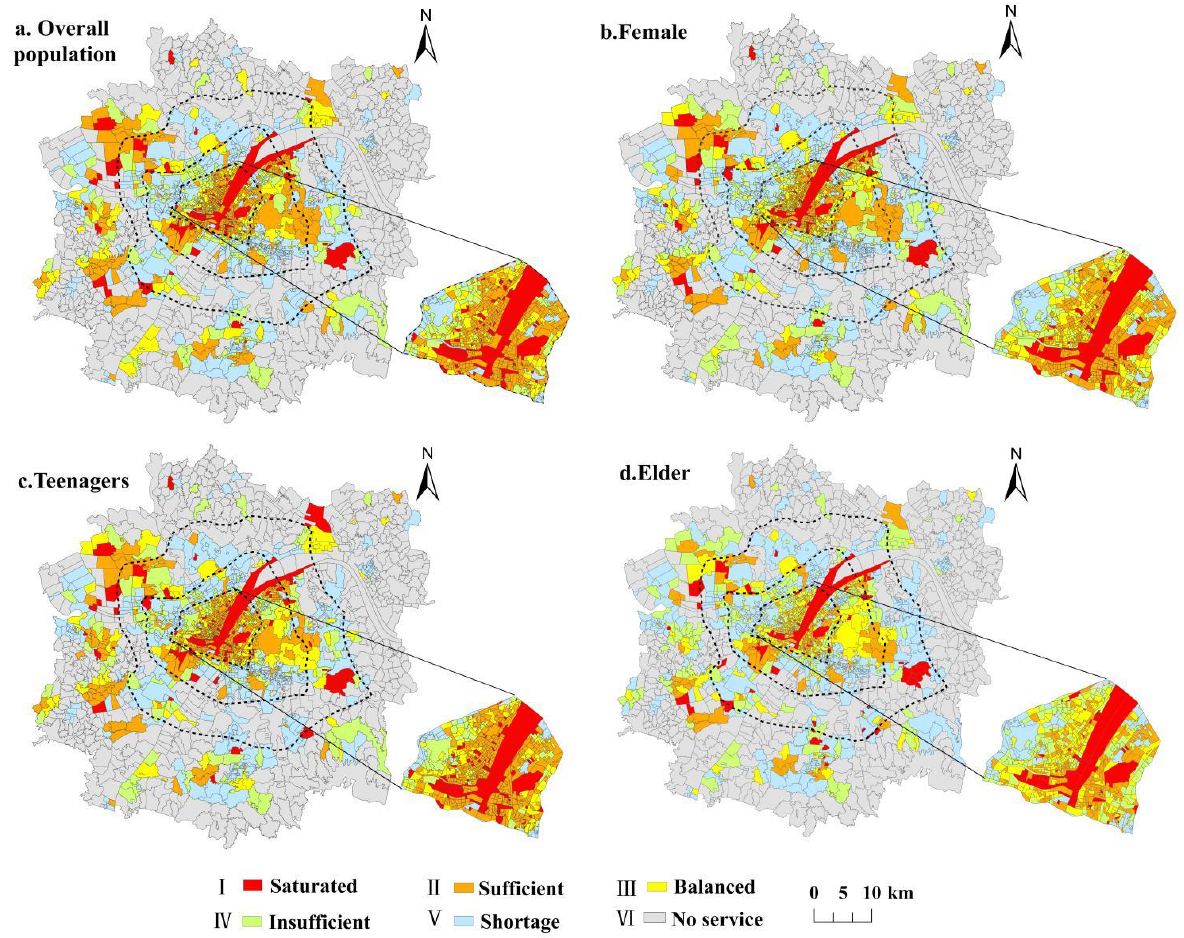
Figure 7. Supply – demand matching relationship of UERS in the urban development area of Wuhan. Figure 7. Supply–demand matching relationship of UERS in the urban development area of